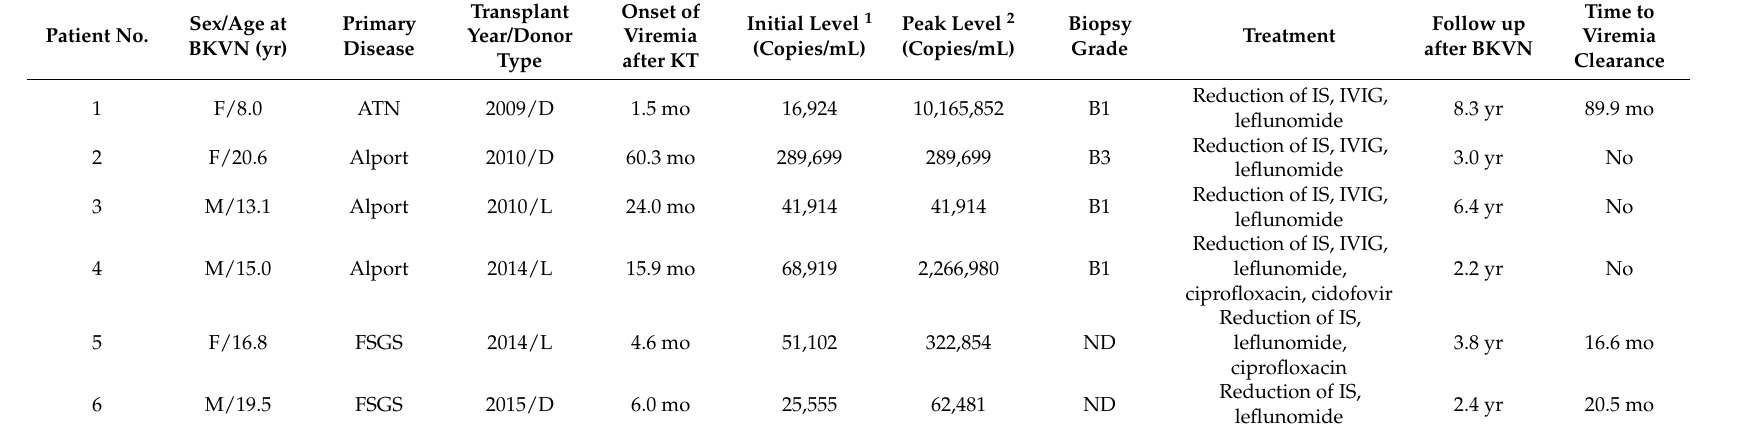
Table 3. The clinical course of patients with